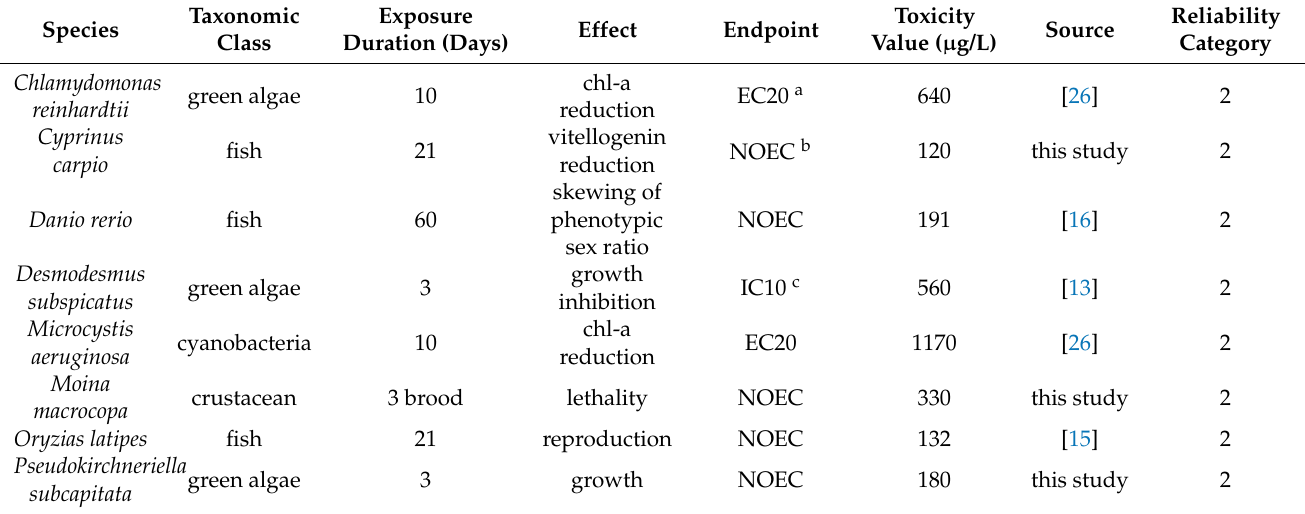
Table 2. The chronic toxicity data used for the derivation of predicted no-effect concentration (PNEC) of benzophenone-3 (BP-3) in this